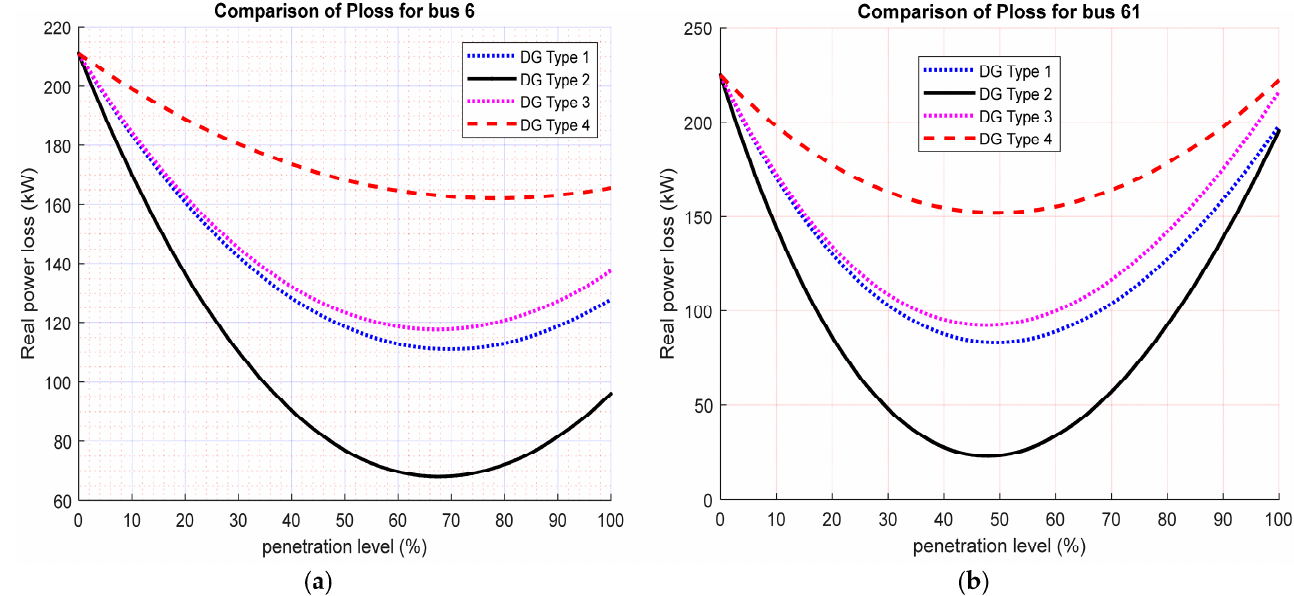
Figure 25. Comparison of real power loss by various DG types interconnected to ( a ) bus 6 of IEEE 33-bus and ( b ) bus 61 of the IEEE 69-bus RDNs.